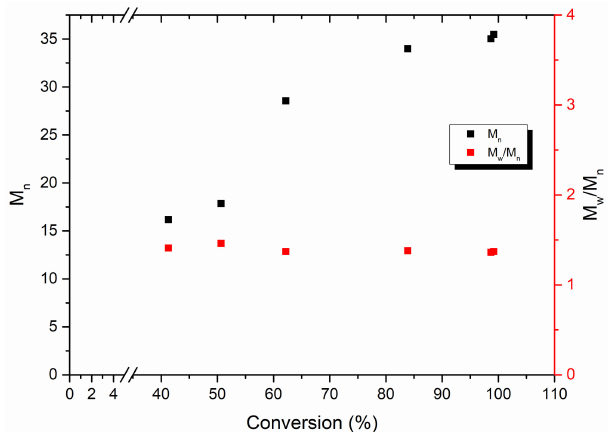
Figure 5. Dependence of the average molecular weight (M n ) (black squares) and polydisper- sity M w /M n (red squares) on the conversion during the polymerization of 1-vinyl-1,2,4-triazole, [AIBN]:[CTA2] = 1:2 mol at 60 ◦